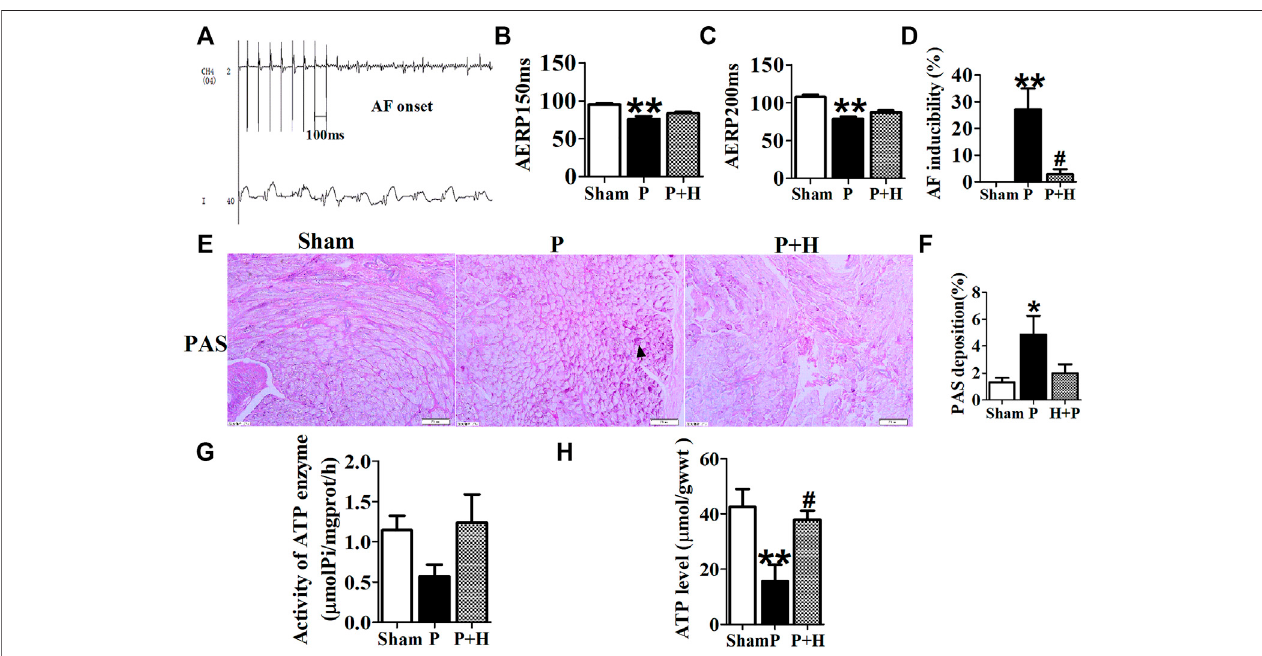
FIGURE 2 | Electrophysiology detection and assay of glycogen and ATP. (A) AF was induced after rapid-pacing. (B,C) AERP150 ms and AERP200 ms, (D) AF inducibility.n=6eachgroup. (EandF) Representativeimagesandstatisticalresultsoftheglycogenaccumulationintheatriaofrabbits,themagni fi cationis×20. (Gand H) Statistical analyzes of activity in ATP enzyme and level of ATP. * p < 0.05 vs. sham group,** p < 0.01 vs. sham group, # p < 0.05 vs. P group, n = 6 each